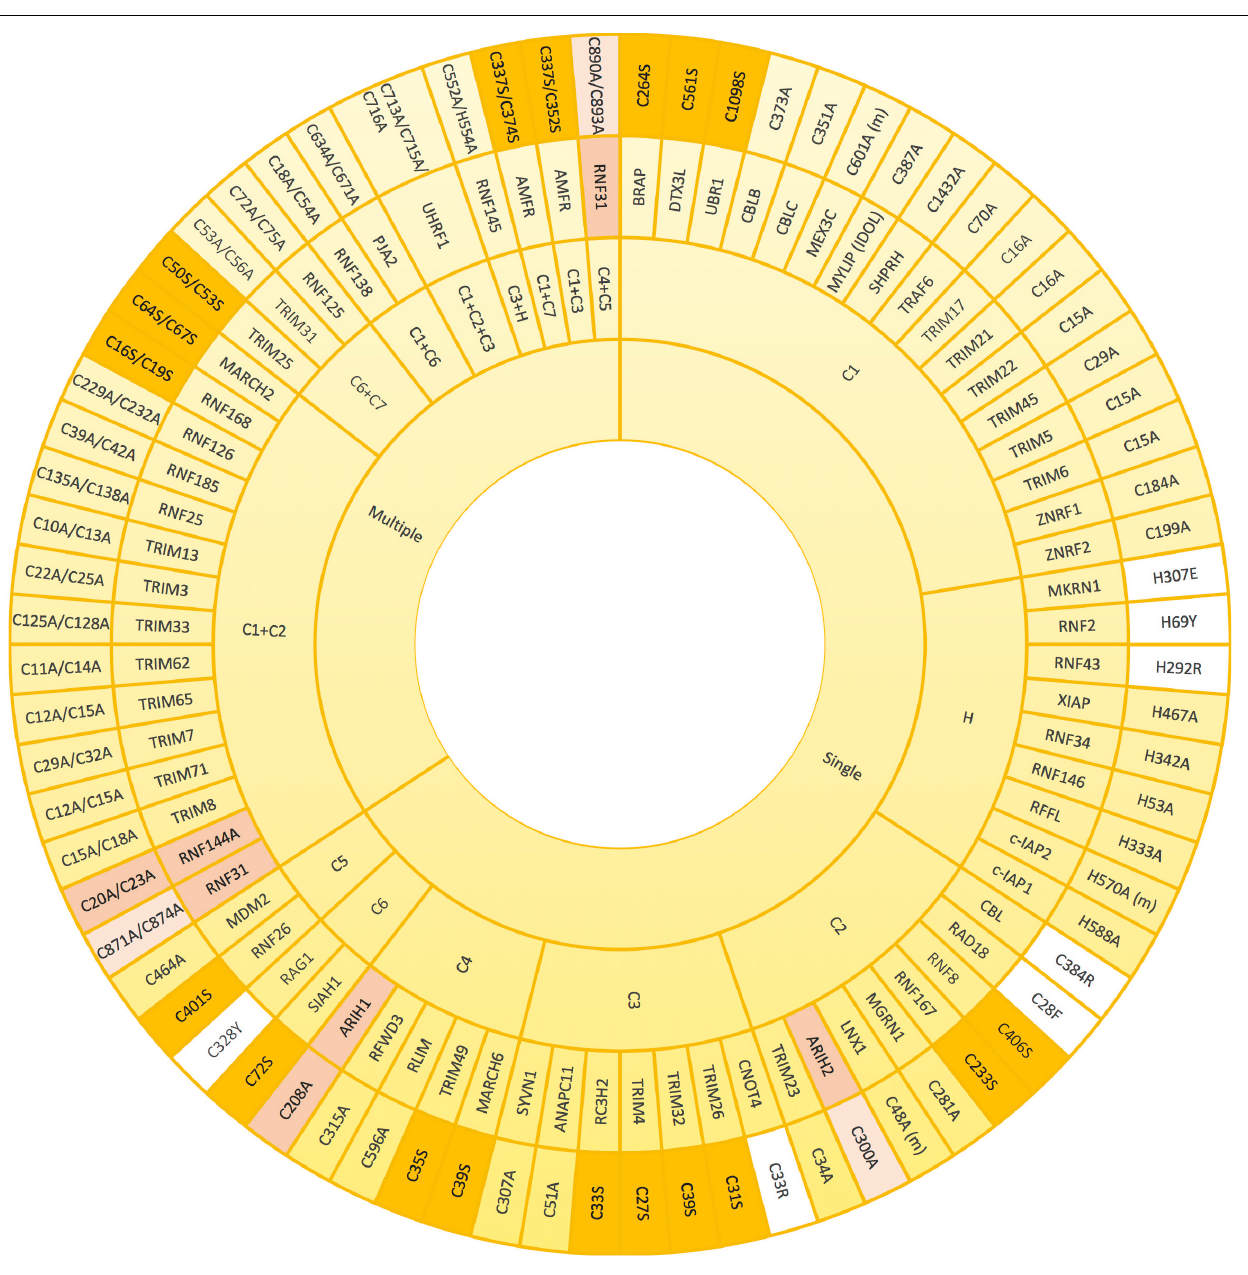
FIGURE 3 | Mutations that alter zinc coordinating residues in RING domains. Wheel diagram showing the reported mutations in RING domains, classified first whether a unique (single) or various (multiple) residues were mutated simultaneously. Most of the inactive E3 enzymes have been obtained by mutating key residues into alanine (yellow). Lack of activity can also be acquired by mutations into serine (orange). Mutations into other residues have been also employed (white). Zinc coordinating residues of the first (pink) and the second (light pink) RING domains in RBR-type E3 ubiquitin ligases (pink) have also be modified in order to achieve inactivation. References to all the mutations shown in this figure are provided in Supplementary Table S1